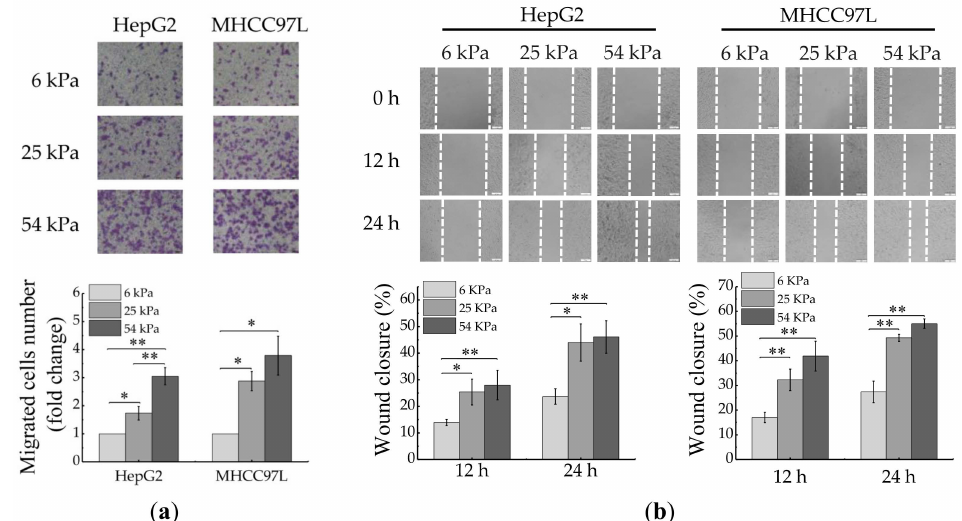
Figure 1. Migration of HCC cells is regulated by ECM sti ff ness. ( a , b ) Transwell assay analysis ( a ) and wound scratch assay analysis ( b ) of HepG2 and MHCC97L cells migration after cultured on di ff erent sti ff ness of hydrogel for 48 h; quantitative analysis is shown below. (Scale bar: 100 µ m; n = 3, * p < 0.05, ** p <